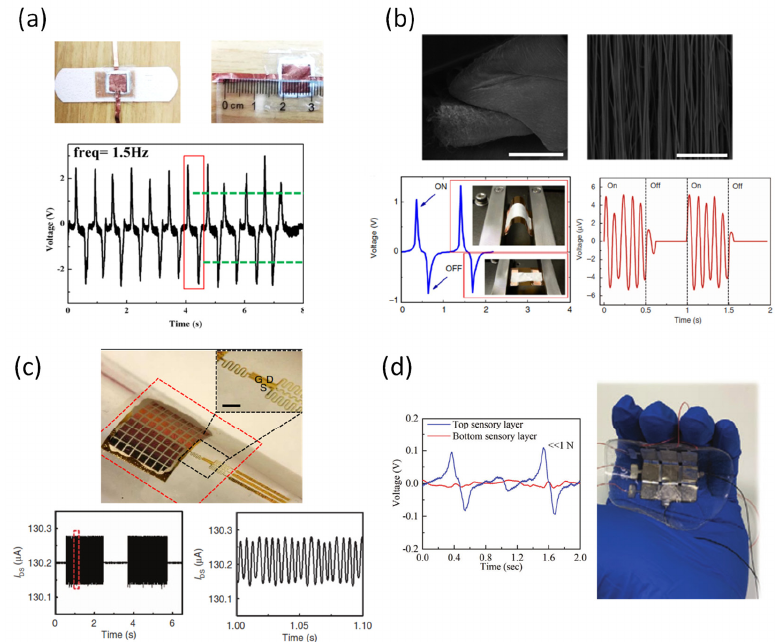
Figure 4. ( a ) Electrospun BaTiO 3 /Poly(vinylidene fluoride) nanocomposite membrane [89]. ( b ) Aligned arrays of nanofibers of poly(vinylidenefluoride-co-trifluoroethylene) for piezoelectric [90]. ( c ) Conformable amplified lead zirconate titanate (PZT) sensor [91]. ( d ) Crosstalk electrodes for spa- tiotemporally distinguishing diverse stimuli [92]. Table 3. Comparative sensing performances of the piezoelectric-based sensor.